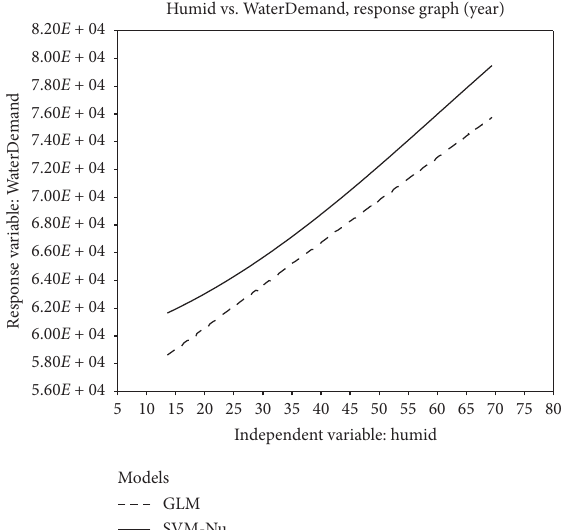
Figure 15: The reaction of water consumption to relative humidity with annual conditions using GLM and SVM-Nu models. Humid vs. WaterDemand, response graph (summer)